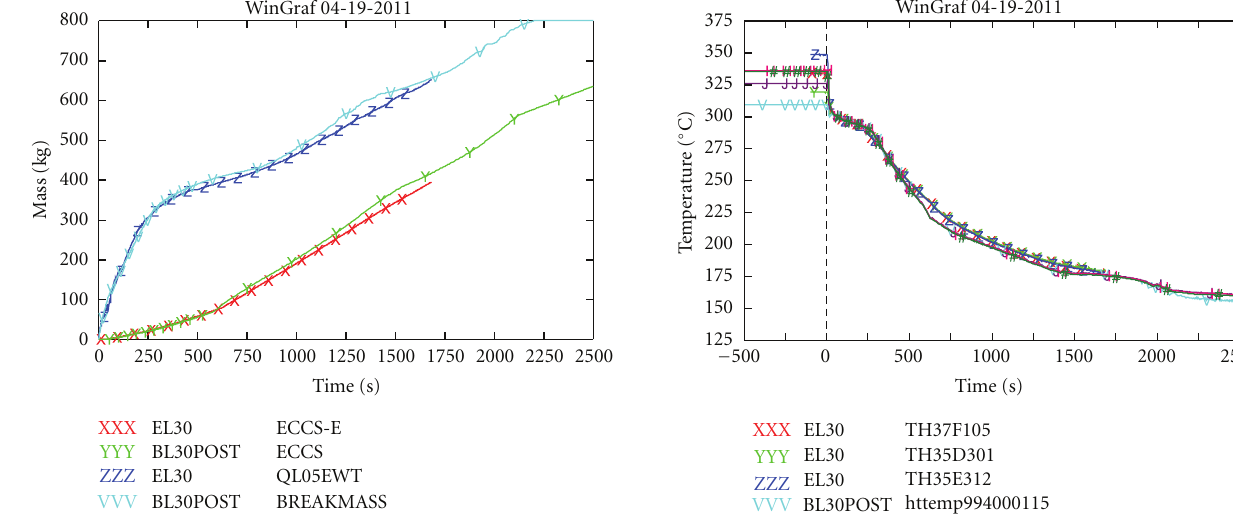
Figure 6: ECCS integral mass flow and integral break flow.